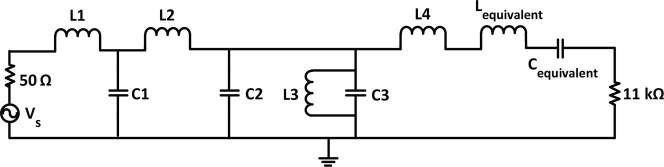
Schematic of a dual resonant rectifier (optimized parameters of the chip components are: L1 = 3.9 nH, C1 = 0.2 pF, L2 = 12 nH, C2 = 1.8 pF, L3′ = 3.9 nH, C3′ = 7.5 pF, L4′ = 11.6 nH, Lequivalent ≅ 1 nH, Cequivalent ≅ 1.3 pF).